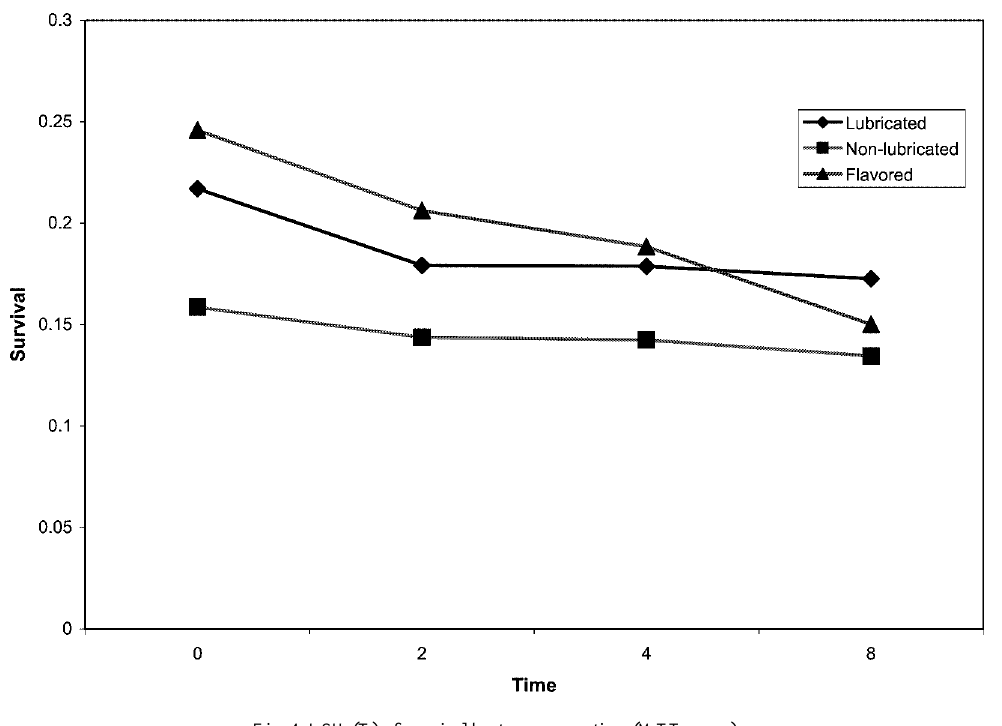
Fig. 4. LSH (T) of survival by type versus time (MTT assay).